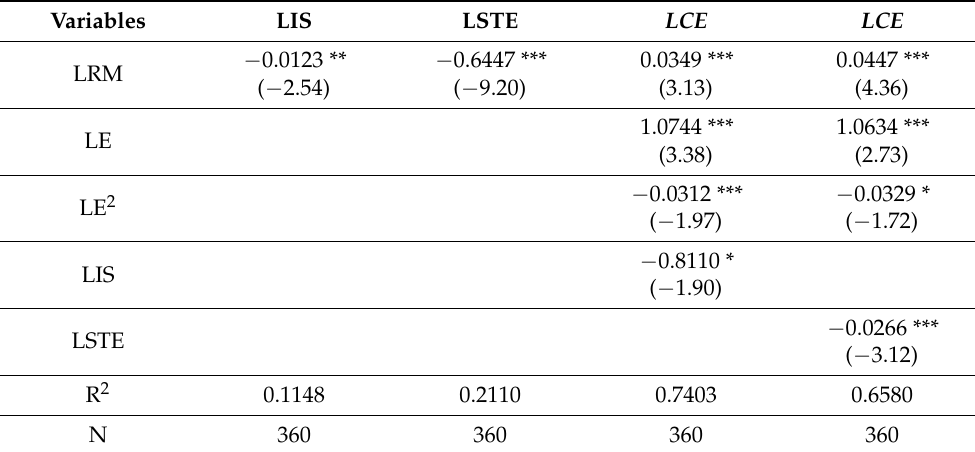
Table 6. Results for the intermediate